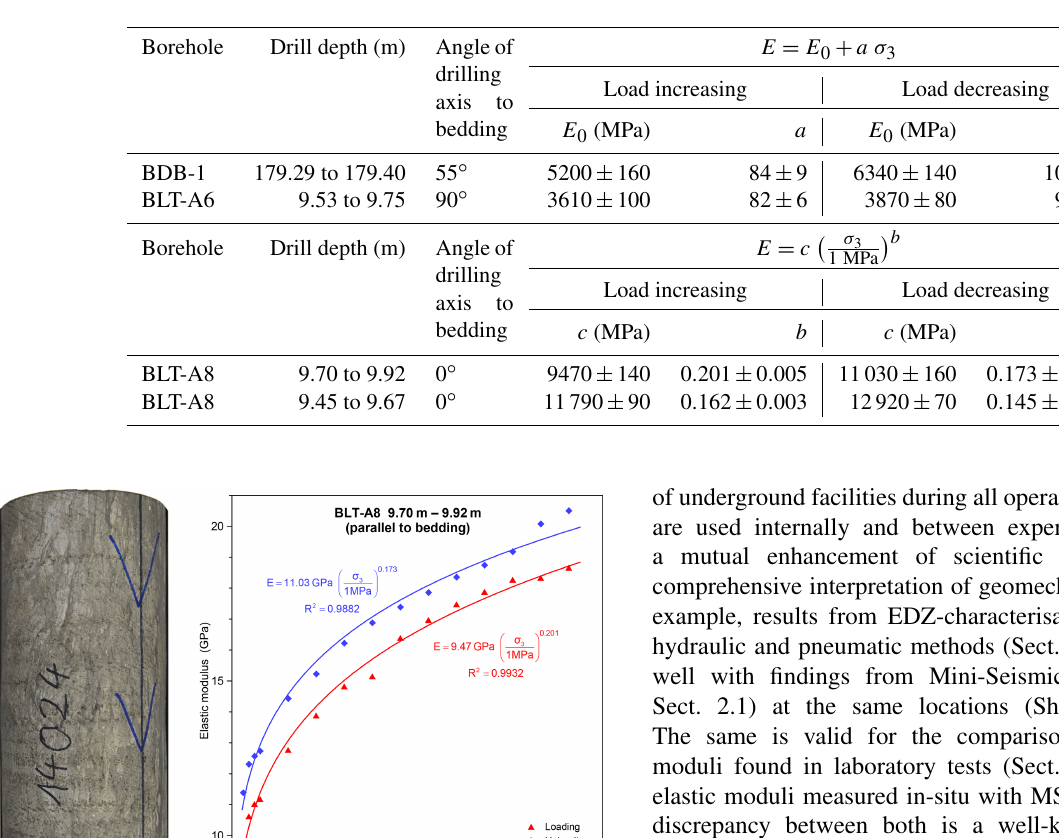
Table 1. Parameters of the dependence of the elastic modulus on the confining pressure for Opalinus Clay samples from Mont Terri rock laboratory.